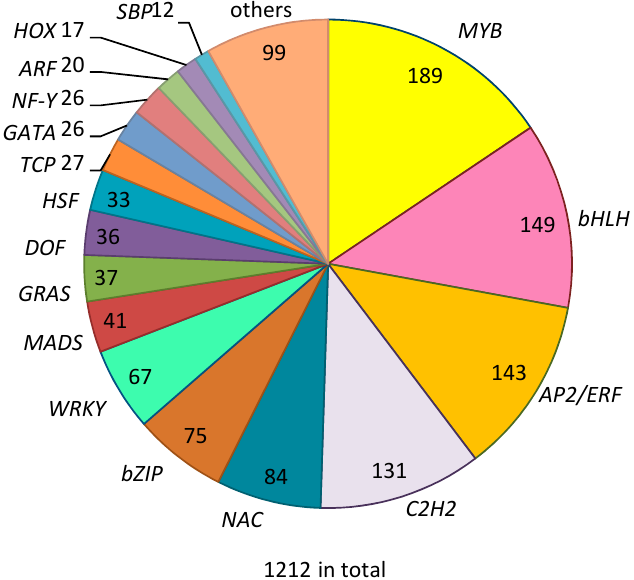
Figure 1. Transcription factor gene families identified in cucumber with numbers indicating number of transcription factor (TF) genes belonging to a particular family.